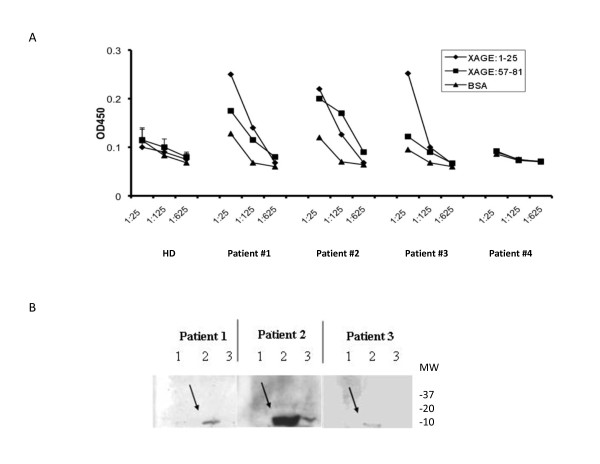
Identification and validation of B cell epitopes from cancer/testis antigen XAGE-1b. (A). ELISA was used to screen candidate peptides from XAGE-1b for recognition by patients' sera. Three patients (#1-3) were positive for either XAGE-1b:1-25 or 57-81. Sera were diluted at 1:25, 1:125, and 1:625 with BSA serving as a control target. The mean OD of 8 HD and the OD of one seronegative patient (#4) are also shown. The use of sera from NSCLC patients for screening is due to higher frequency of Ab against these shared antigens in NSCLC patients. Previous work has shown that peptide epitopes identified using one type of sera are equally recognized by sera from other cancer patients. (B). Western blots confirmed recognition of the full-length XAGE-1b protein. Lane 1, 2, and 3 contained, respectively, lysate from 293 cells transfected with a control plasmid, a plasmid encoding XAGE-1b (denoted with an arrow), and lysate from LNCaP-CL1 cells (expressing XAGE-1b but at a much lower level based on real-time PCR, data not shown).